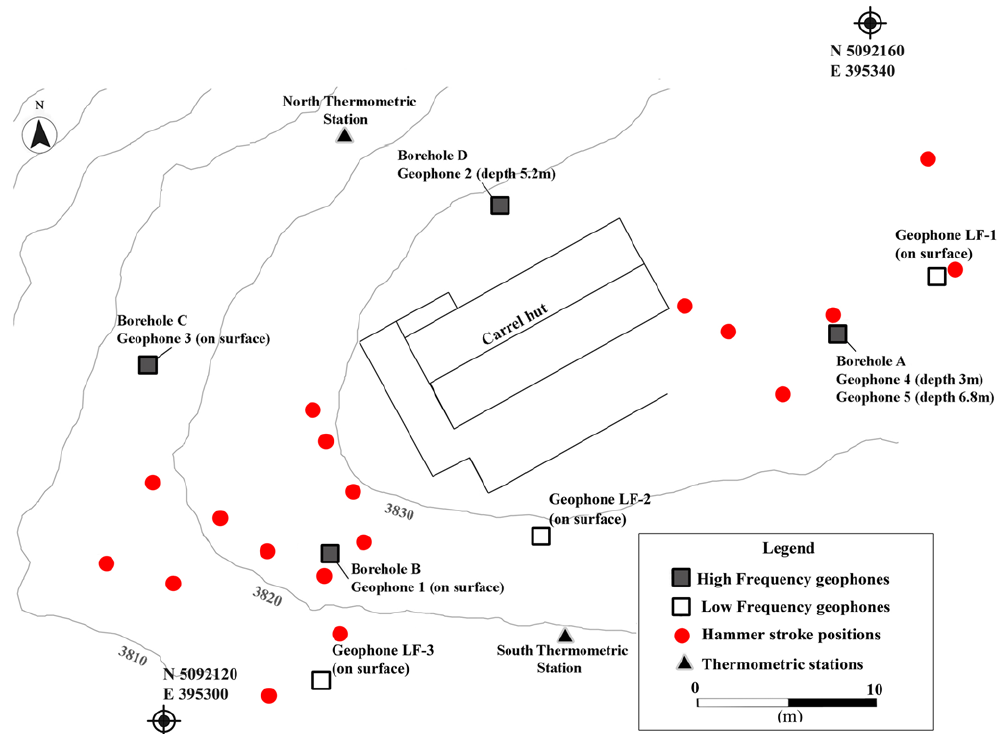
Fig. 2. The J. A. Carrel hut and the position of the geophones, of the hammer strokes and of the thermometric